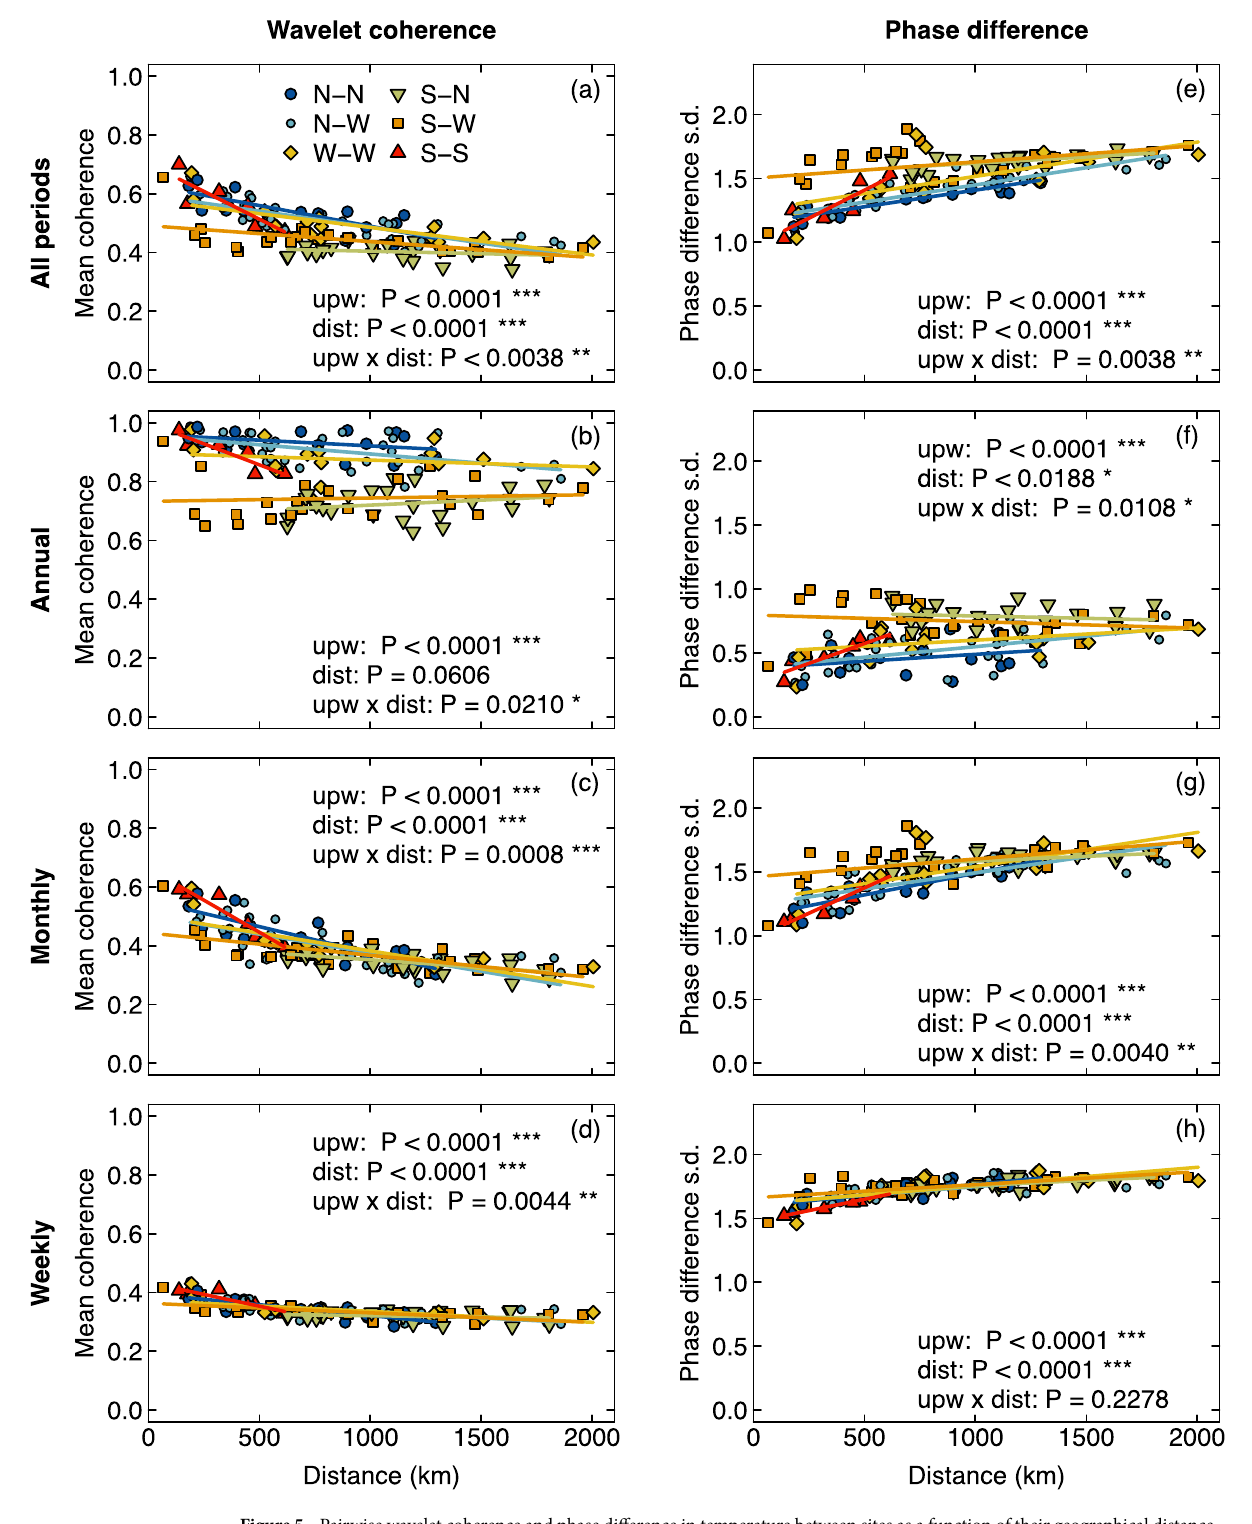
Figure 5. Pairwise wavelet coherence and phase difference in temperature between sites as a function of their geographical distance. Columns represent mean coherence ( a – d ) and phase difference spread measured in standard deviations ( e – h ). For reference, sites that experience phase synchrony will be characterized by a near zero standard deviation in phase difference. Rows represent all (2–889 days), annual (300–400 days), monthly (15–45 days) and weekly (2–10 day) periods. Data points are coded by color and shape based on each paired sites’ upwelling condition combination. Strong upwelling pairs (S–S) are represented in red triangles, Strong– Weak upwelling pairs (S–W) are represented in orange squares, Weak upwelling pairs (W–W) are represented in yellow diamonds, No–Weak upwelling pairs (N–W) are represented in small light blue circles, No upwelling pairs (N–N) are represented in large dark blue circles, and Strong–No upwelling pairs (S–N) are represented in green inverted triangles. P -values are based on ANCOVA relating average pairwise coherence or standard deviation of phase difference in temperature between sites to their upwelling condition and geographical